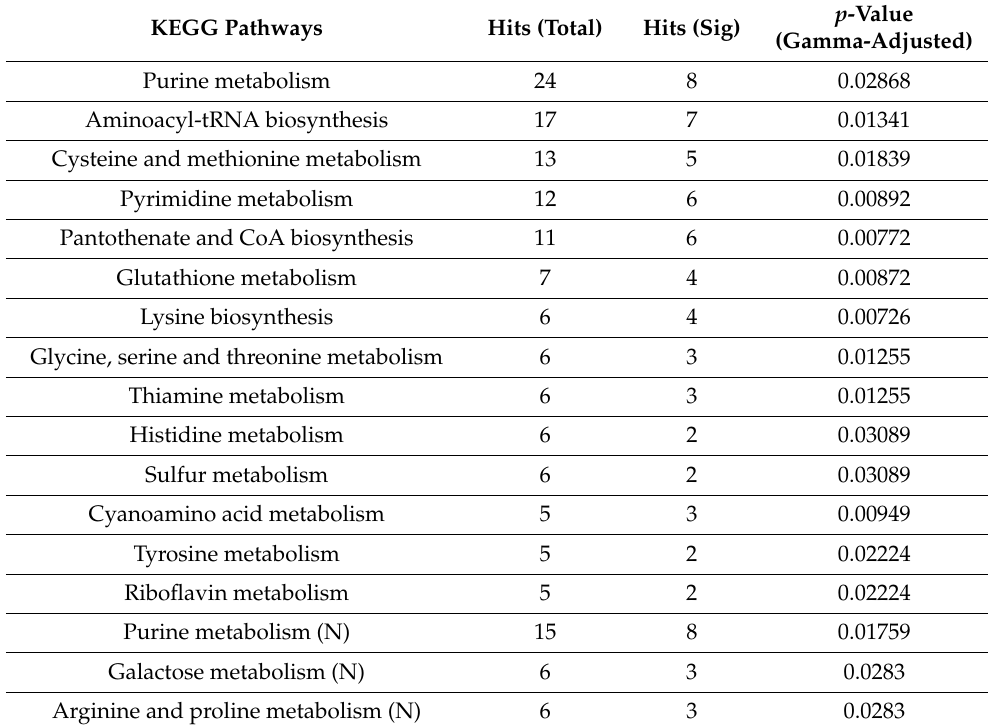
Table 1. Enriched pathways ( p value < 0.05) for comparison between Comamonas sp. 12022 MYb131 and combination. The enriched pathways are mainly identified from positive mode. Pathway names ending with (N) indicate that the results are based on negative